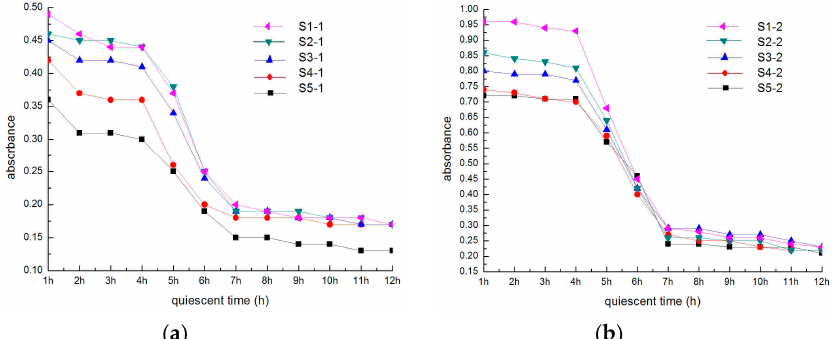
Figure 3. Impact of time on the absorbance of CNT dispersion. ( a ) 0.3% nano-Ce(SO 4 )2, ( b ) 0.6% nano-Ce(SO 4 ) 2.